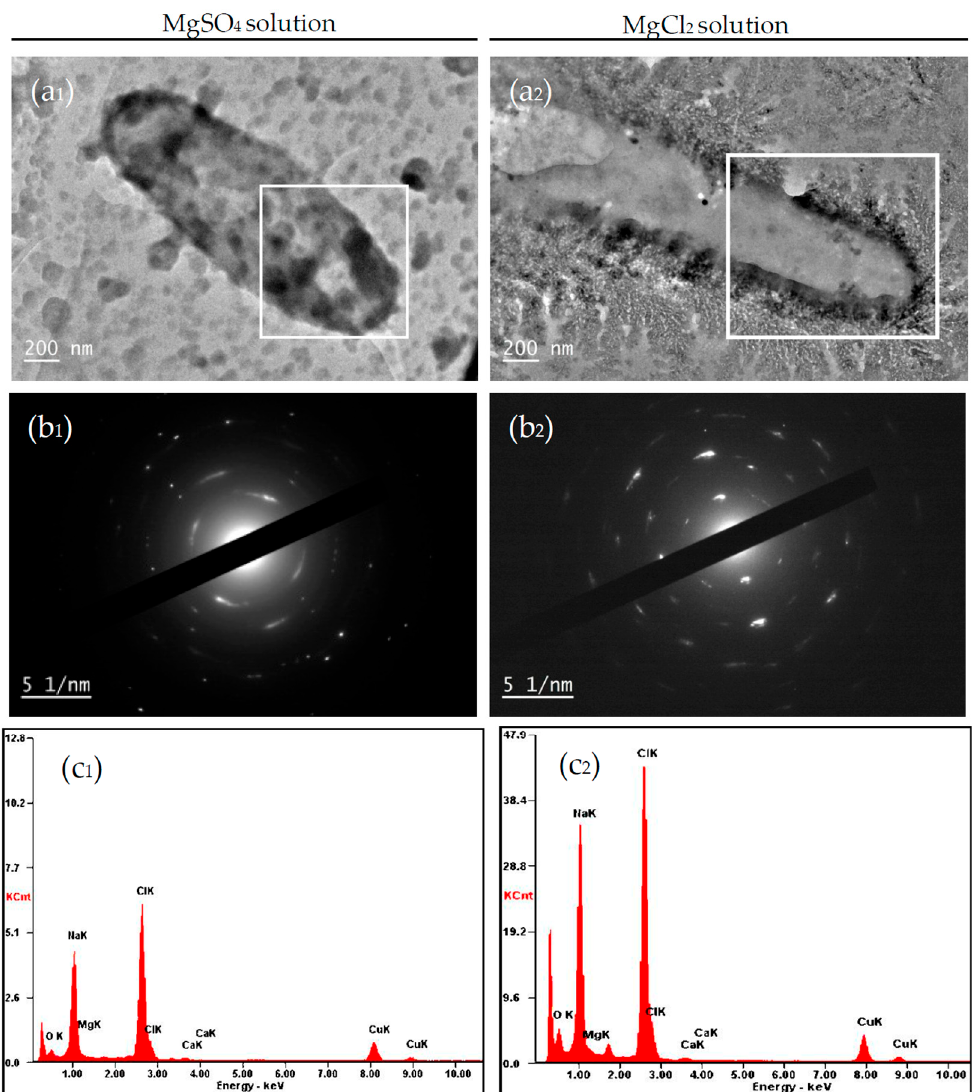
Figure 10. HRTEM, SAED, and EDS analysis of LD532 bacteria cell: ( a 1 ) HRTEM analysis of LD532 bacteria cell at an Mg/Ca ratio of 2 in MgSO 4 solution; ( b 1 , c 1 ) SAED and EDS analyses of LD532 bacteria cell marked by the white square; ( a 2 ) HRTEM analysis in the experimental group at Mg/Ca molar ratio of 2 in MgCl 2 aqueous solution; and ( b 2 , c 2 ) SAED and EDS analyses of LD532 bacteria cell marked by the white square.